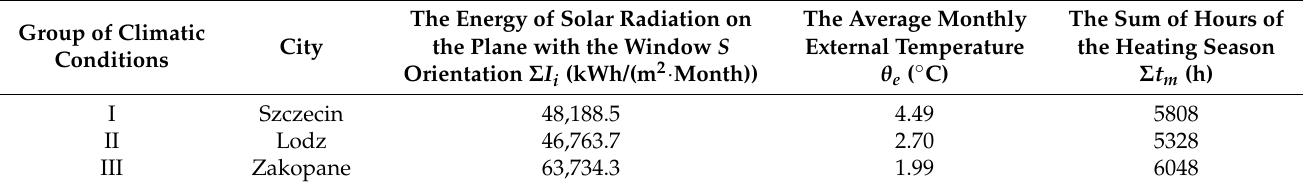
Table 4. Averaged climate characteristics for the heating season in selected cities (own elaboration based on [20]). Group of Climatic Conditions